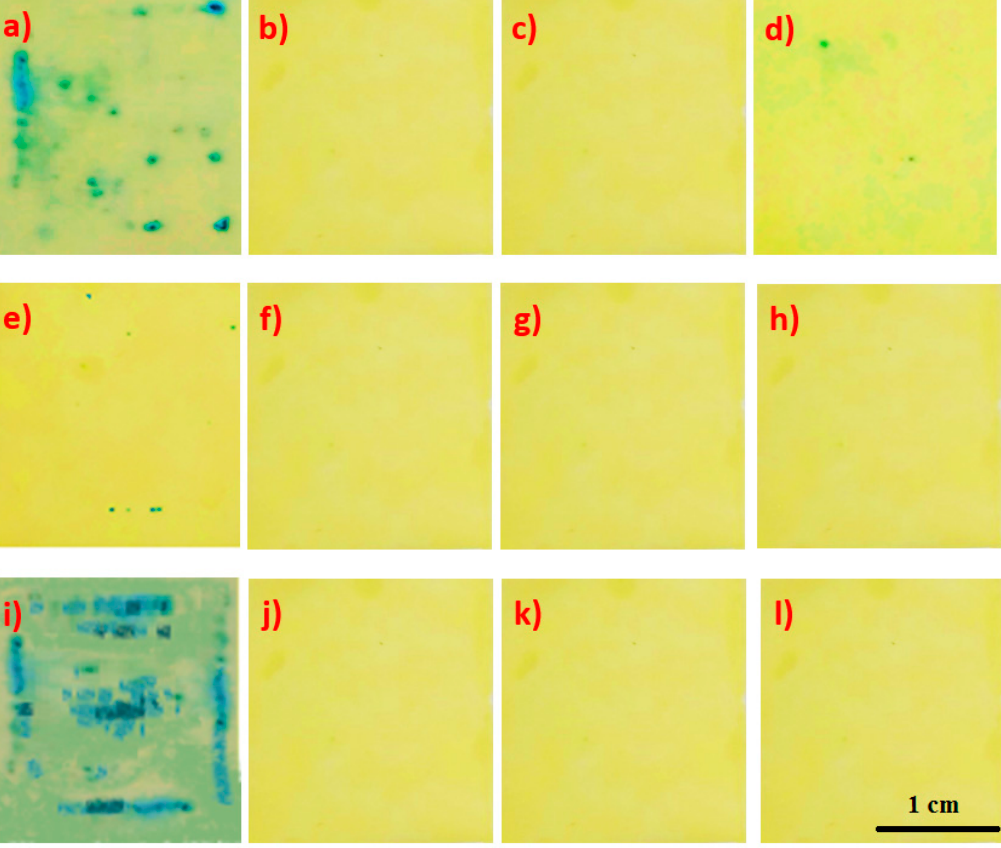
Figure 21. Analysis of the integrity of the tested samples: ( a ) sample modified with molybdenum, ( b ) sample modified with calcium, ( c ) sample modified with strontium, ( d ) sample modified with zinc, ( e ) sample modified with copper, ( f ) sample modified with cadmium, ( g ) sample modified with barium, ( h ) sample modified with cerium, ( i ) reference sample—pure metal without a conversion coating, ( j ) reference sample coated with the Mayr manganese coating, ( k ) reference sample with manganese coating additionally covered with Mayr mineral oil, and ( l ) reference sample covered with the Mayr zinc conversion coating.